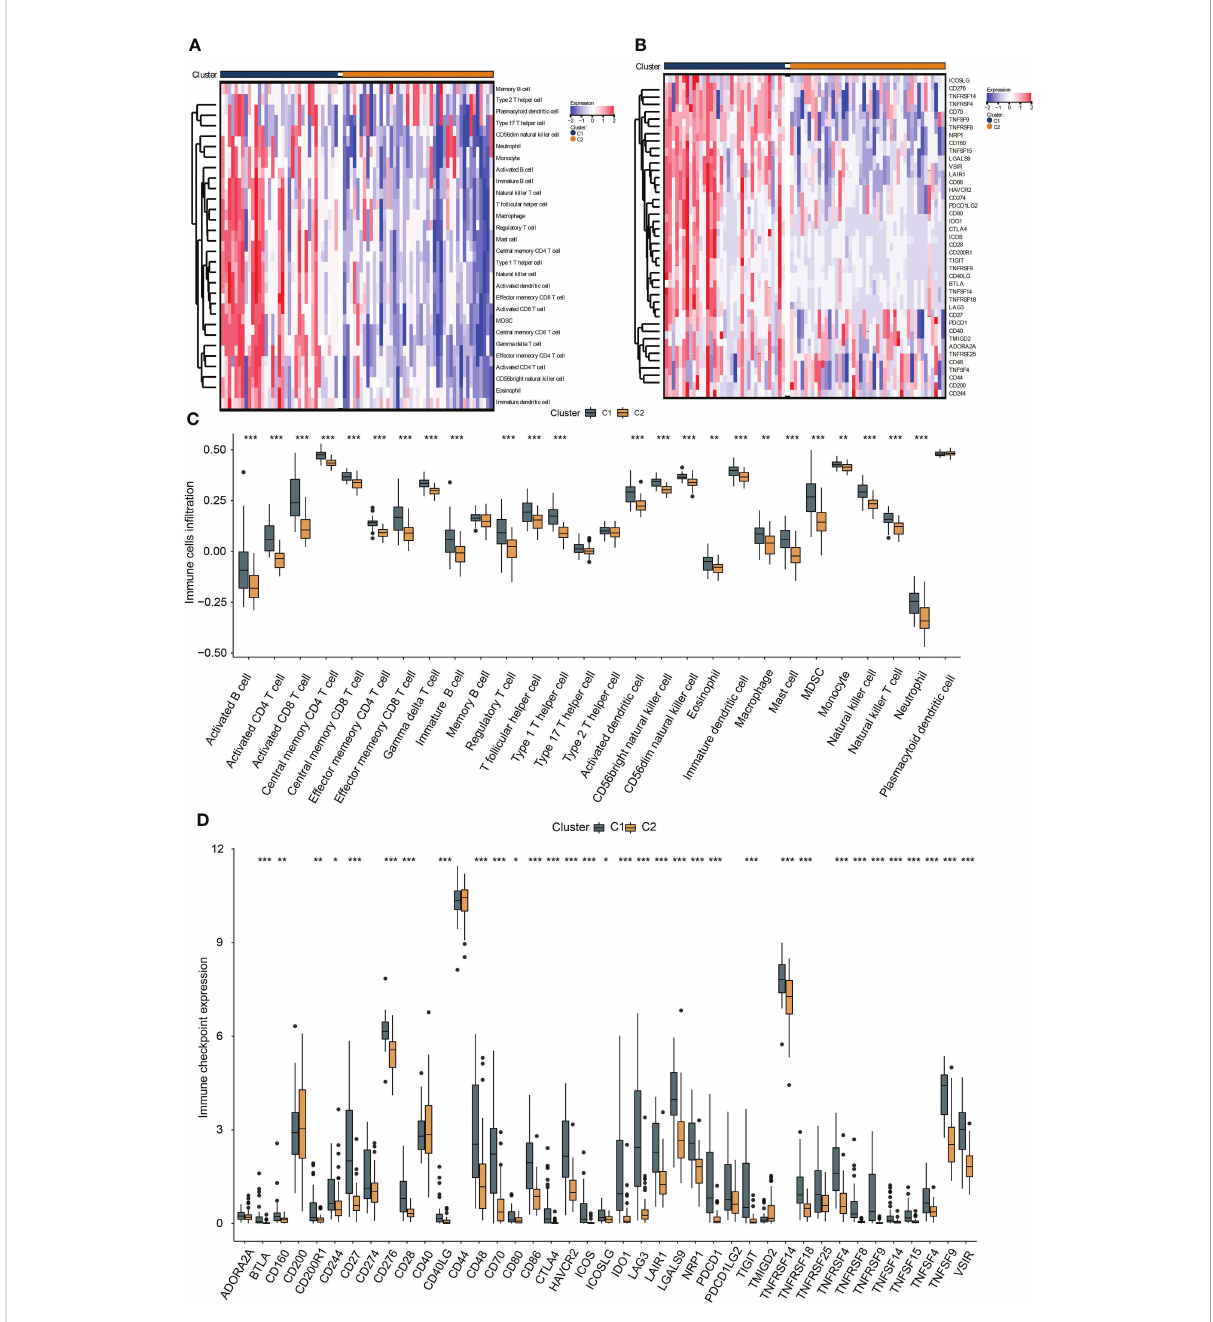
FIGURE 2 The association between hypoxia and immunocyte and immune checkpoints. The heat map presents the immunocyte in fi ltration difference (A) and the expression variation of the immune checkpoints (B) between subtypes, and their quanti fi cation results of immunocyte in fi ltration (C) and immune checkpoint expression (D) were exhibited in the box plots, *, **, *** represents p-value < 0.05, 0.01, and 0.001,